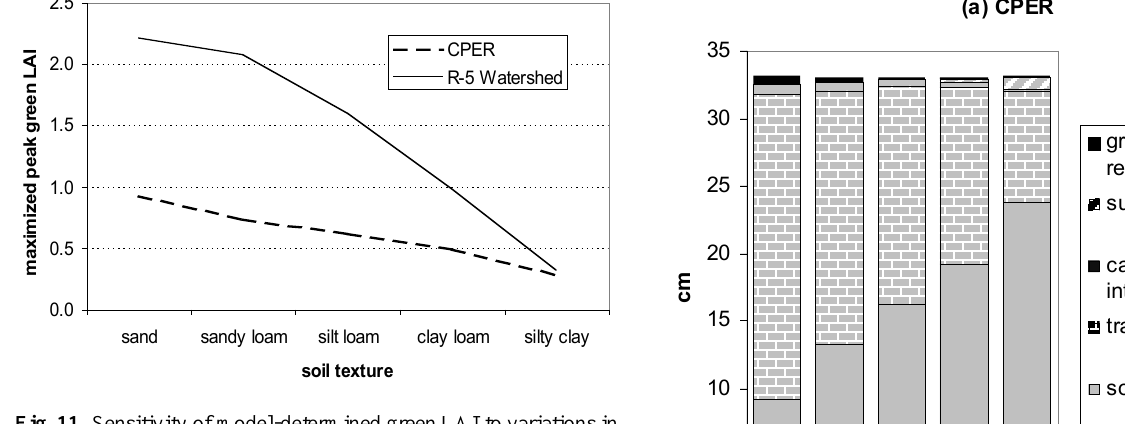
Fig. 11. Sensitivity of model-determined green LAI to variations in soil texture for: (a) the CPER, and (b) the R-5 watershed.